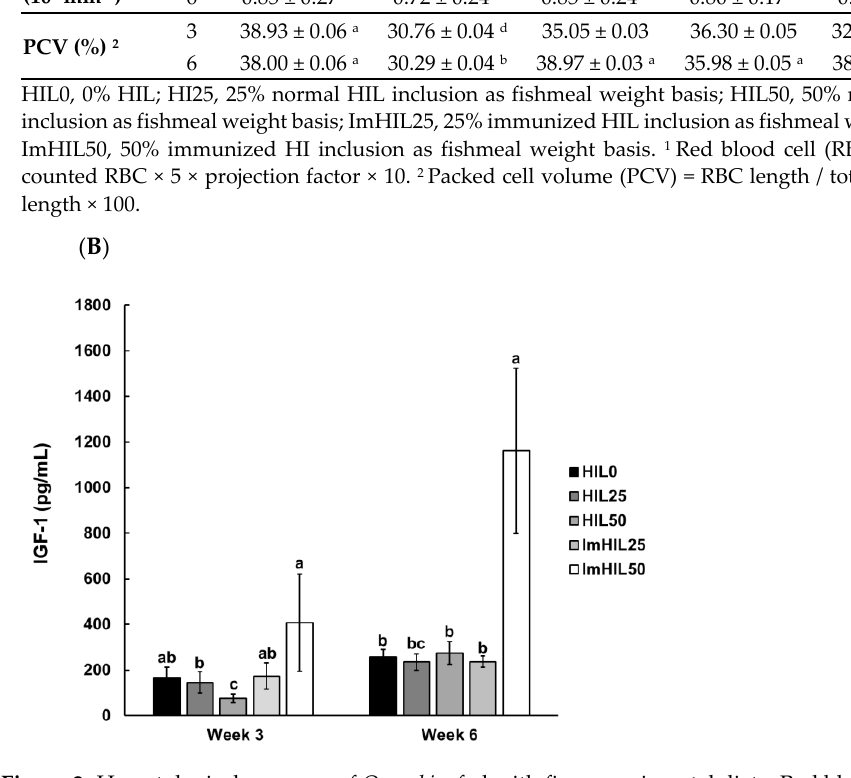
Figure 2. Hematological response of O. mykiss fed with five experimental diets. Red blood cell (RBC) count, packed cell volume (PCV) ( A ), and insulin-like growth factor-1 (IGF-1) level ( B ) in O. mykiss blood serum were measured. HIL0, 0% HIL; HI25, 25% normal HIL inclusion as fishmeal weight basis; HIL50, 50% normal HIL inclusion as fishmeal weight basis; ImHIL25, 25% immunized HIL inclusion as fishmeal weight basis; ImHIL50, 50% immunized HIL inclusion as fishmeal weight basis. Values were taken as a mean of triplicate analyses. Vertical error bars represent standard error of the mean, and lowercase alphabetic characters represent significant differences ( p < 0.05) among groups at each week 3 and week 6 as determined by Duncan’s multiple range test, respectively (n = 9, 3 tanks, 3 fish per tank).